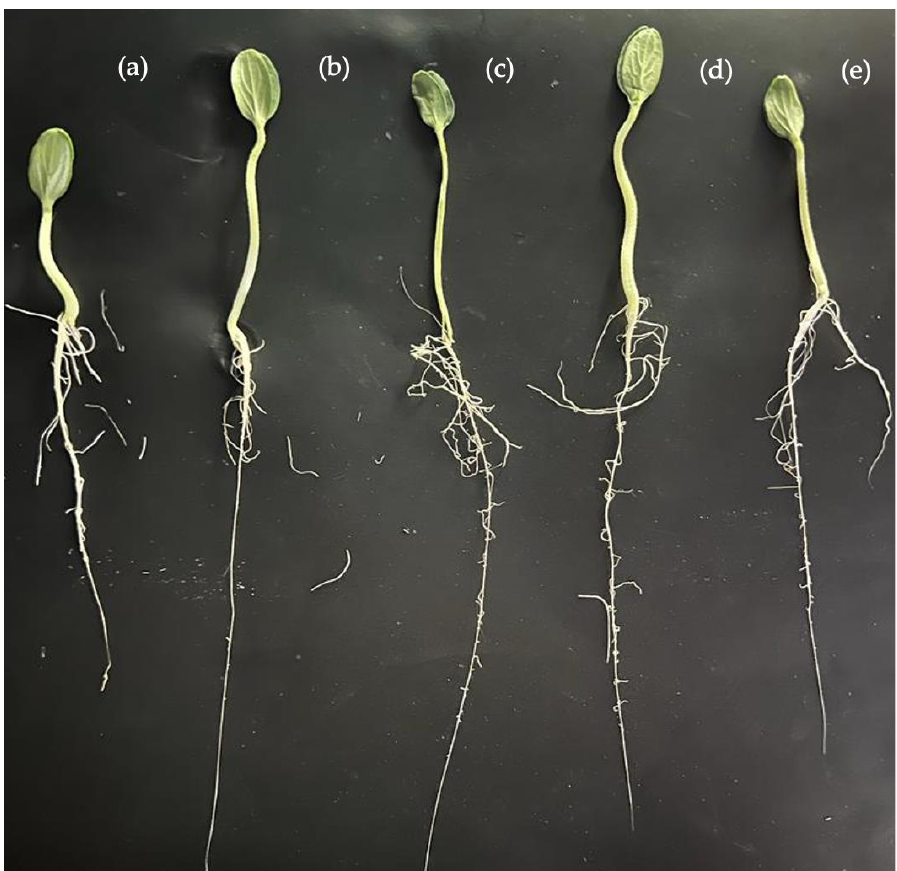
Figure 1. Cucumber seedlings at 7 days old, whose seeds were inoculated with plant-growth-promoting rhizobacteria: ( a ) control without any rhizobacteria inoculation, ( b ) Bacillus cereus (KBEndo4P6), ( c ) Acinetobacter radioresistens (KBEndo3P1), ( d ) Pseudomonas paralactis (KBEndo6P7), and ( e ) Sinorhizobium meliloti (KBEkto9P6).